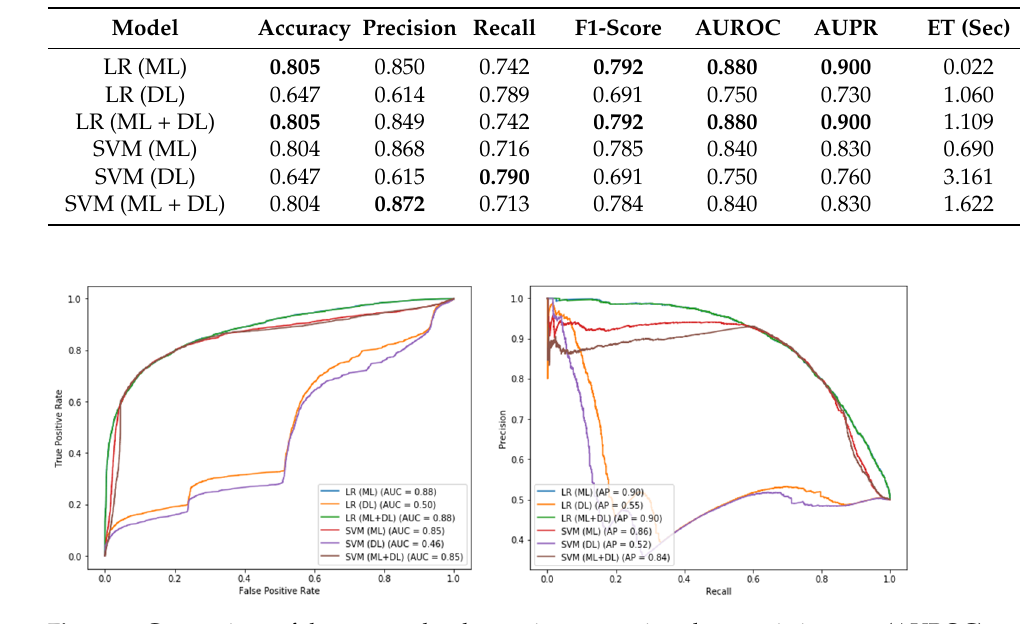
Figure 5. Comparison of the area under the receiver operating characteristic curve (AUROC) and area under the precision–recall curve (AUPR) for the stacking ensemble model.